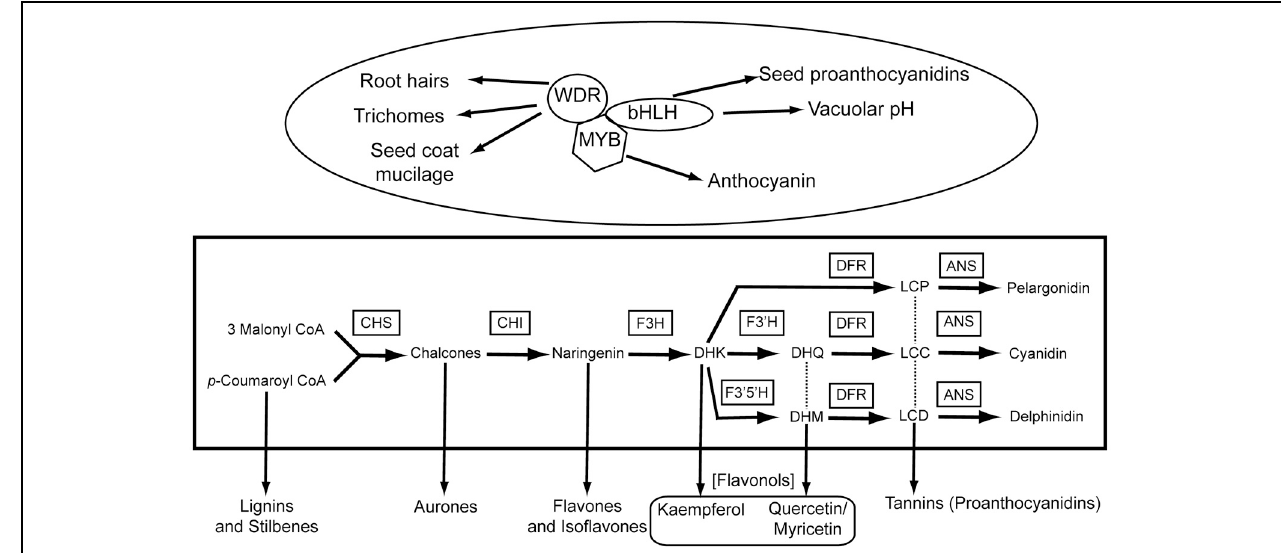
FIGURE 1 | A schematic of the core anthocyanin biosynthetic pathway (ABP; rectangle) and its regulation (ellipse). The core enzymes of the ABP are listed as abbreviations above the arrows in boxes, while the products of each enzymatic reaction are listed next to the arrows. The hexagon labeled “MYB” can refer to either R2R3-MYB or R3-MYB proteins. The MBW complex is known to regulate the ABP, as well as several other aspects of epidermal cell differentiation (connected by arrows). The precise ABP targets